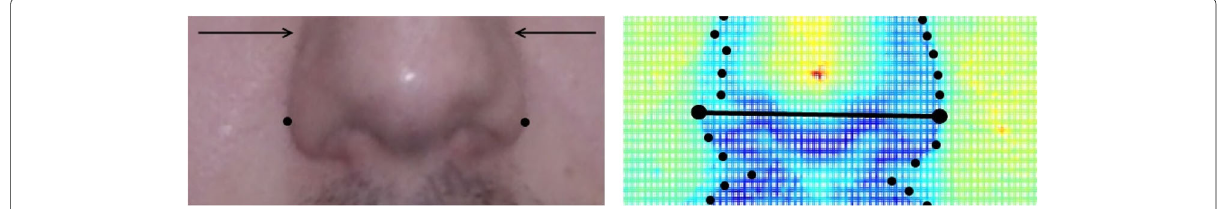
Fig. 7 Example of determining specific characteristic points of the